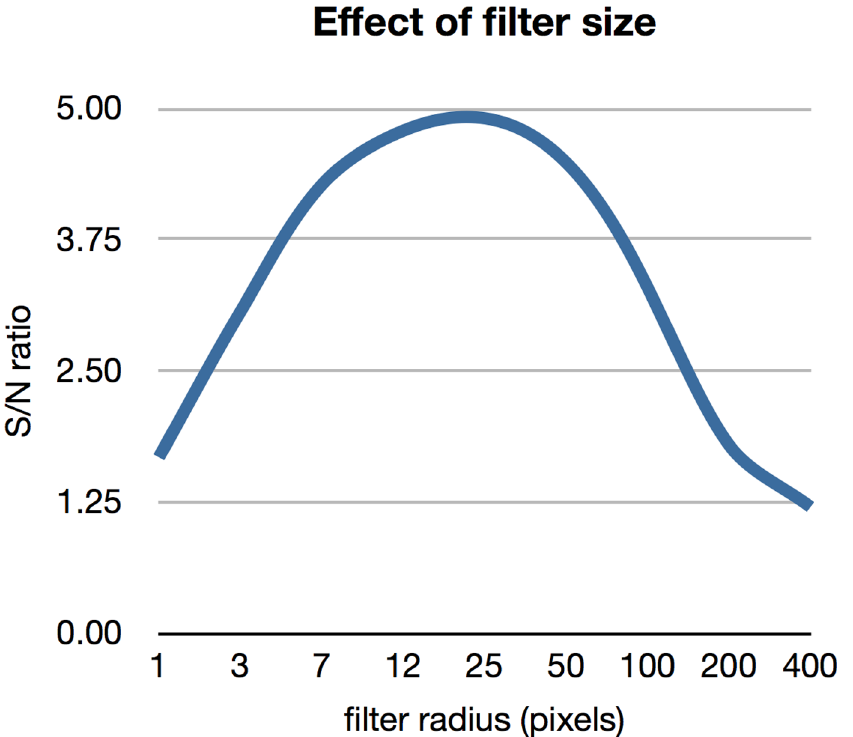
Fig 2. The effect of the filter size on the signal to noise ratio. The signal to noise ratio increases with a larger filter up to a point where it starts to decrease again. Data for a single image